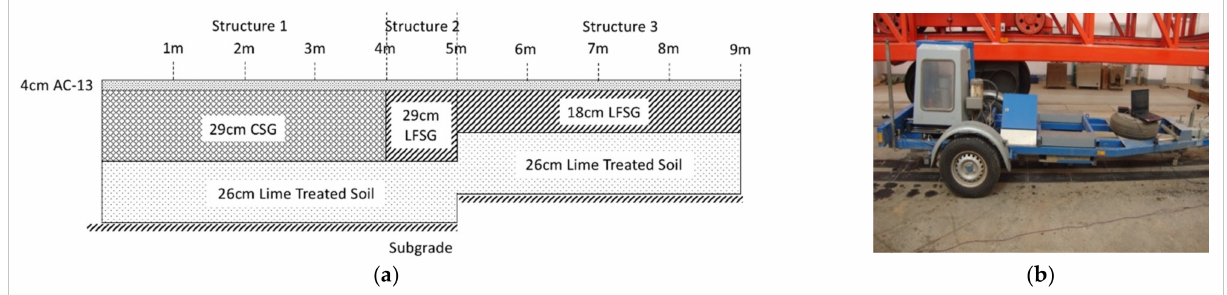
Figure 3. Full-scale pavement structure design ( a ) and FWD test in the full-scale pavement ( b